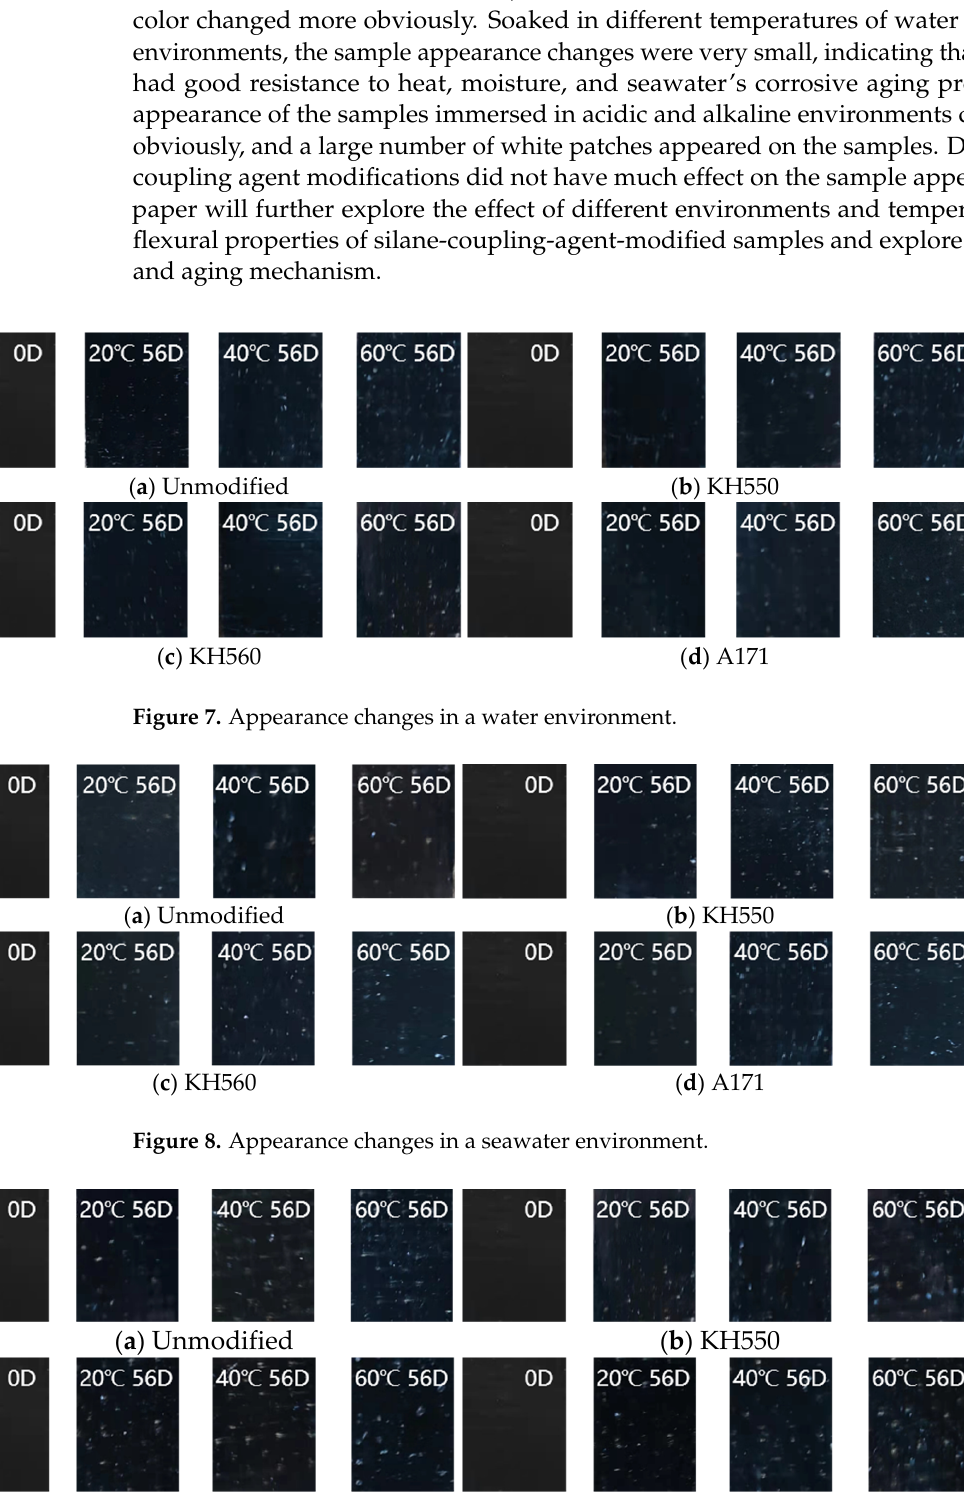
Figure 6. Mechanism of action of a silane-coupling-agent-modified BFRP.